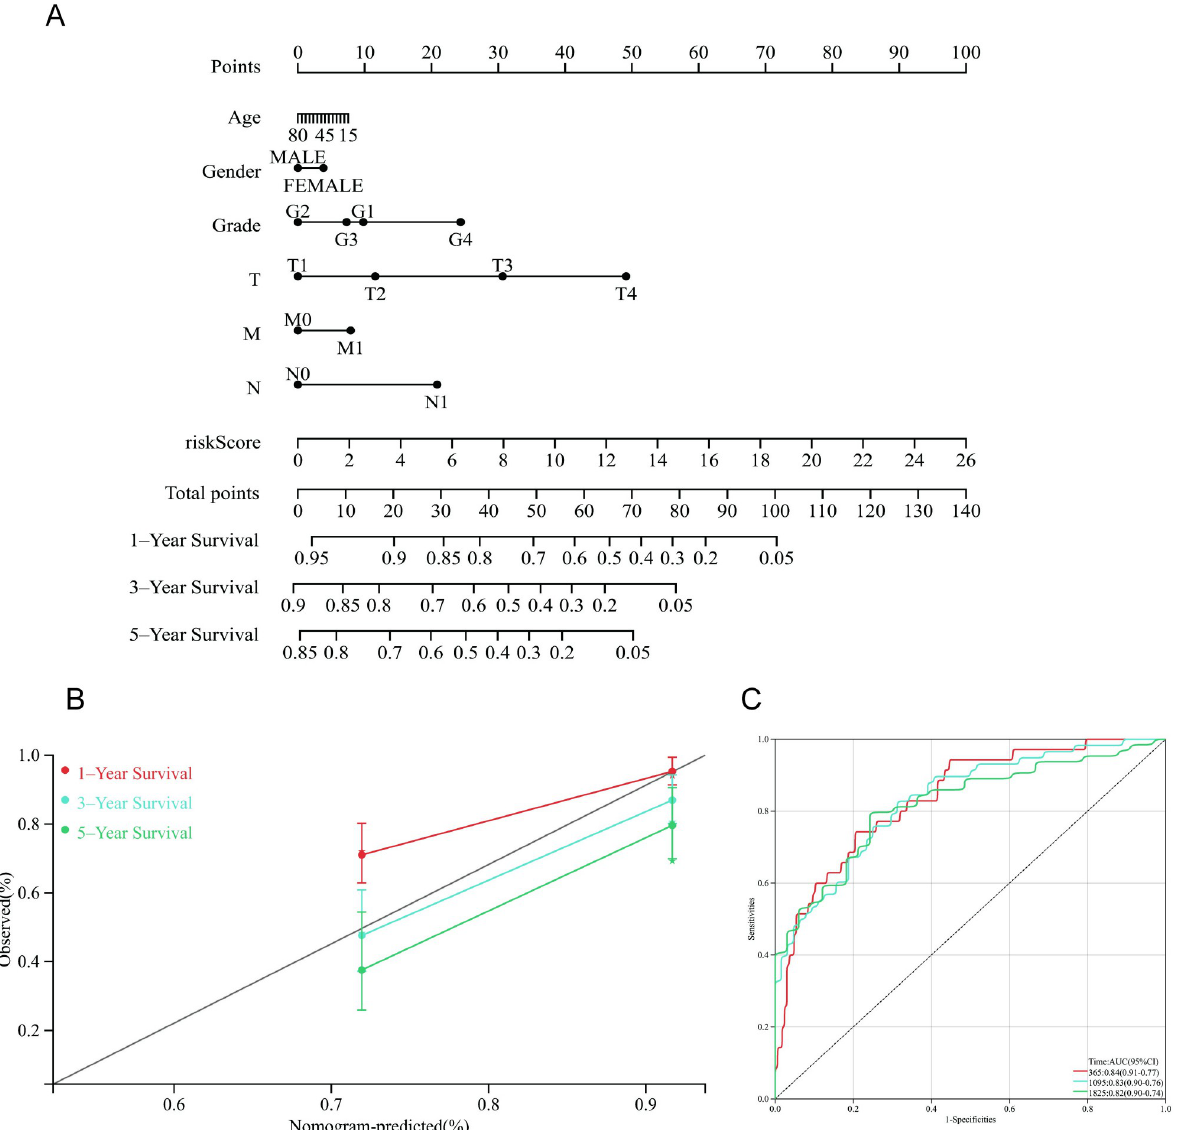
Fig 5. Drawing and validation of the nomogram. (A) 1-, 3-, and 5-year OS of HCC patients predicted by the nomogram. (B, C) The calibration plots and ROC curves for predicting 1-, 3-, and 5-year